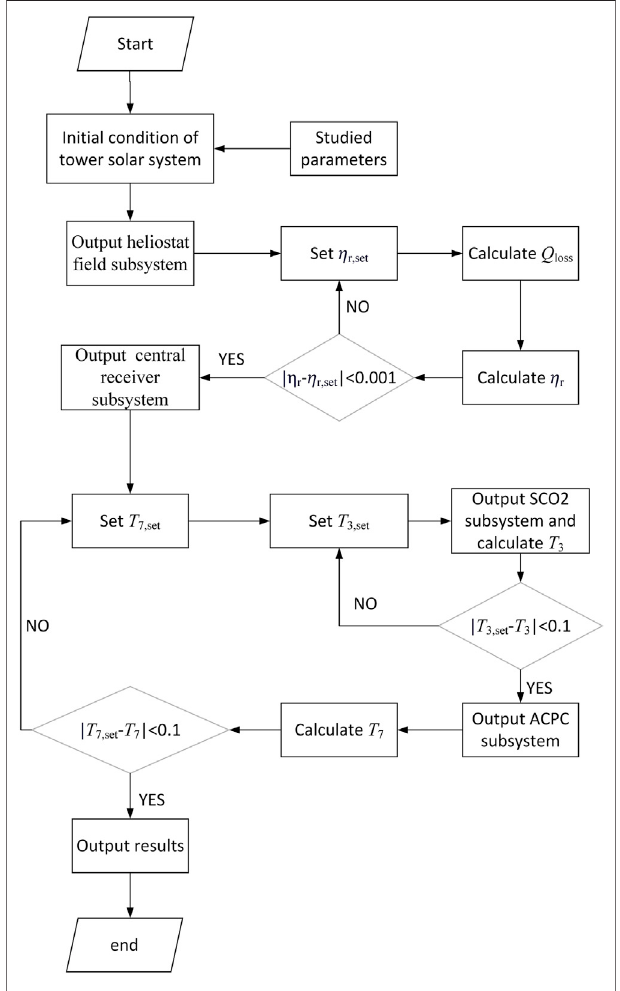
FIGURE 2 | Logical calculation fl ow